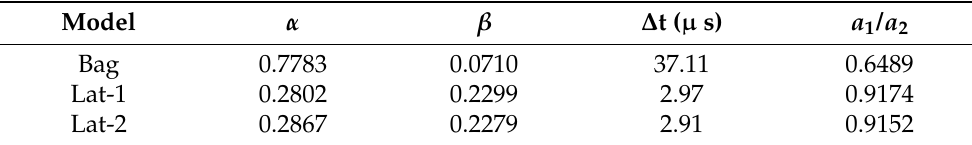
Figure 2. Evolution of the total energy density along the QCD transition for the three considered equations of state. Time was normalized in terms of the corresponding transition duration. Table 2. Duration and beginning of the QCD